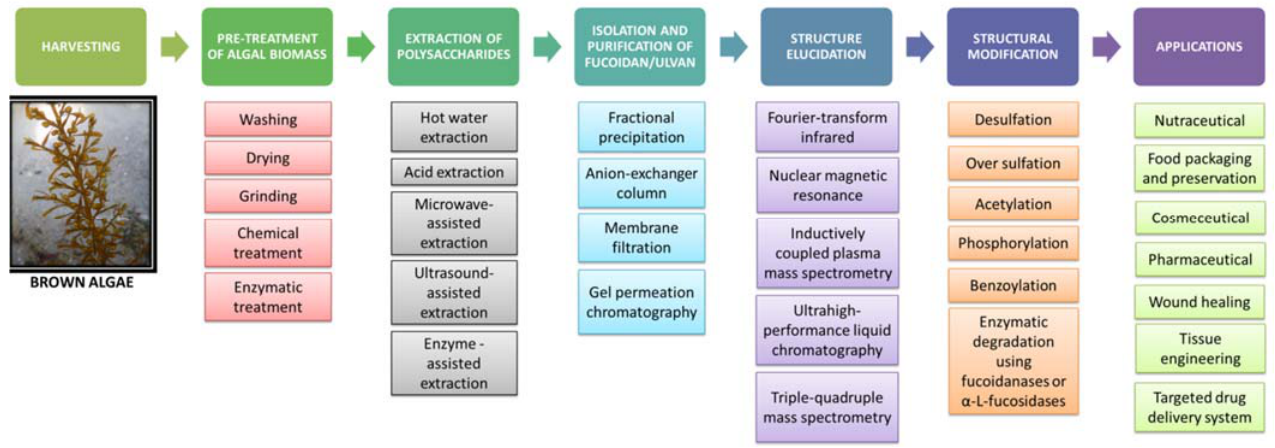
Figure 2. Processes in the extraction, purification and applications of fucoidan.